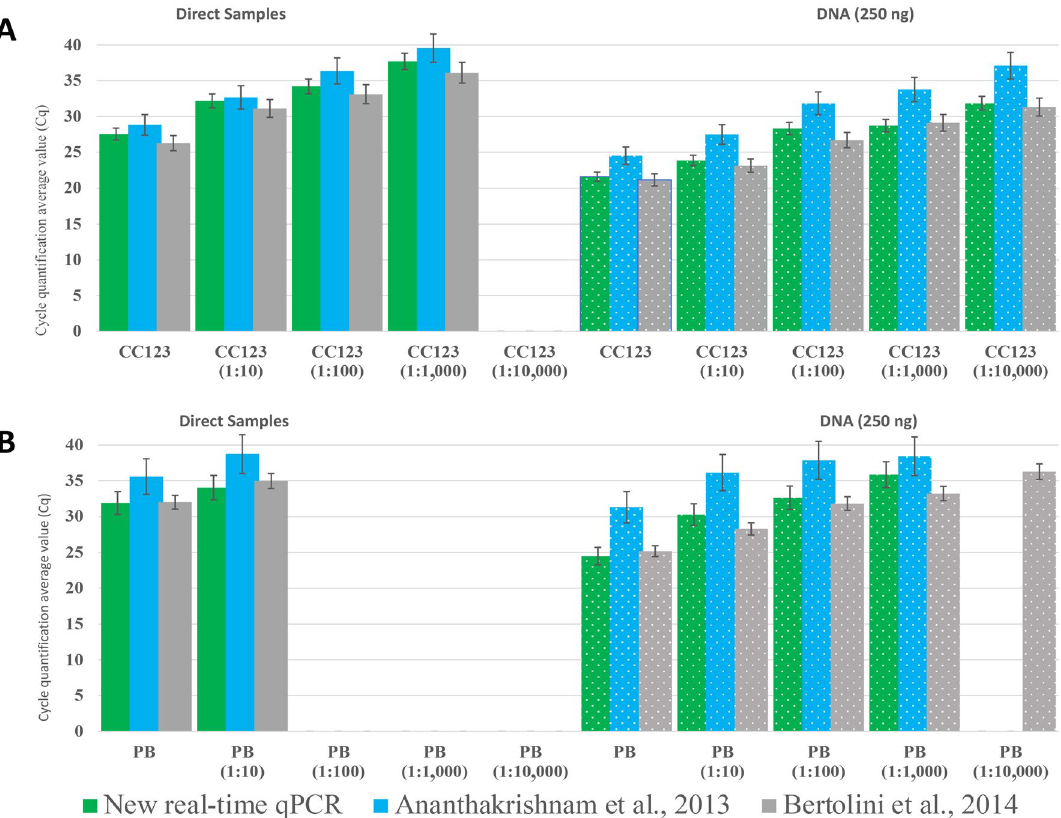
Figure 2. Relative sensitivity (average of C q values) of the new real-time qPCR protocol designed in this study, performed with both direct samples (solid texture) and DNA purifications (dotted texture), in comparison with another two real-time PCR protocols described by Ananthakrishnan et al. 48 and Bertolini et al. 46 . ( A ) CaLas- infected Citrus sinensis cv. Valencia sample (CC123) diluted in healthy plant material. ( B ) CaLsol-infected Solanum tuberosum sample (PB) diluted in healthy plant material. Bars represent standard